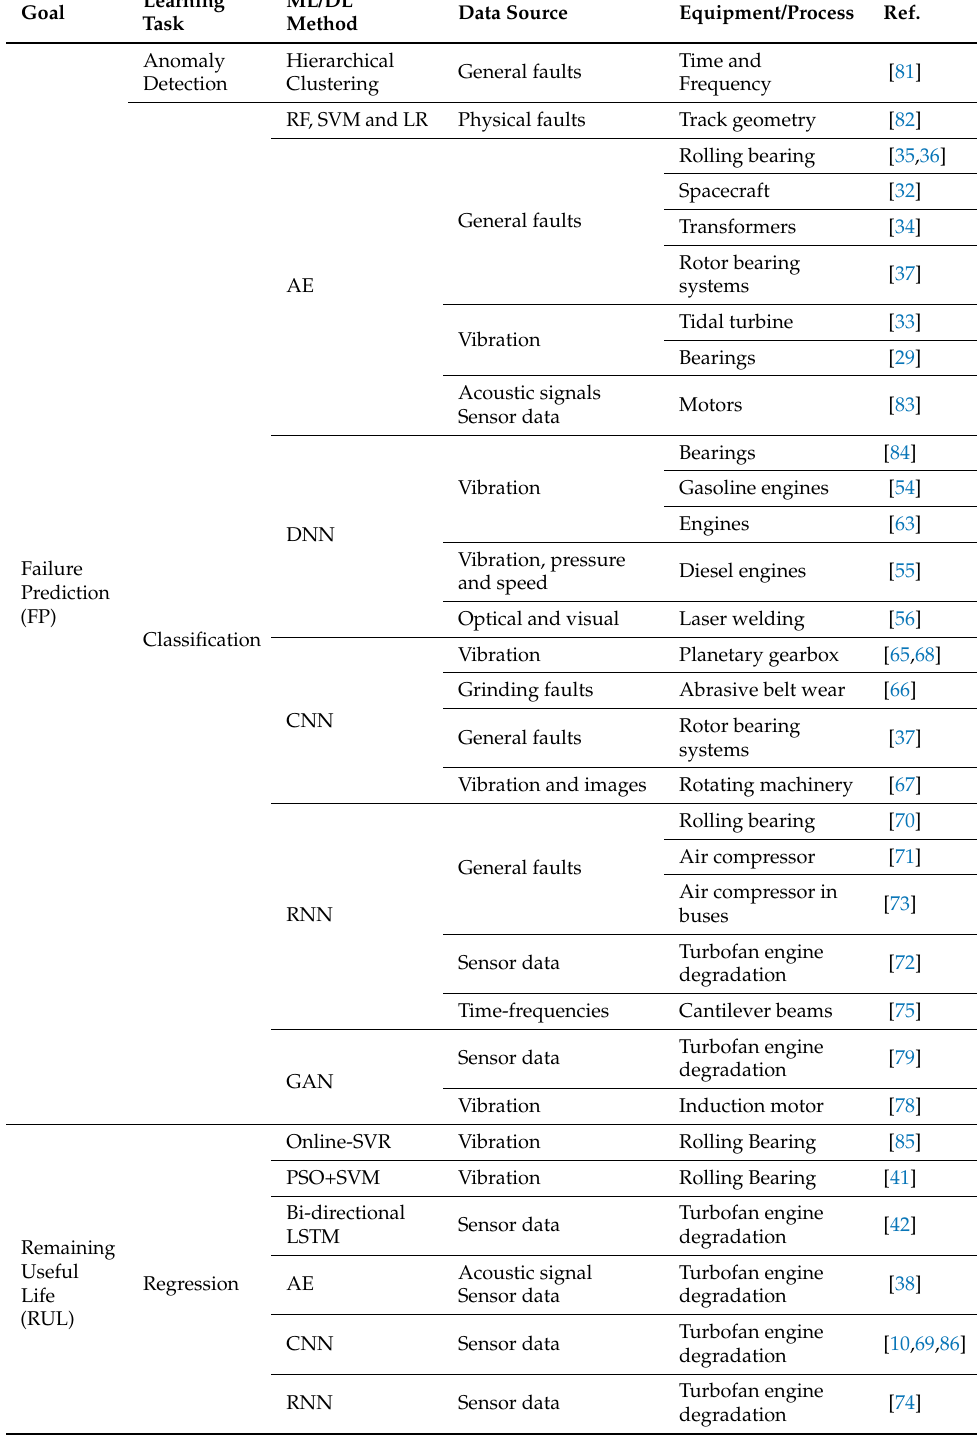
Table 1. ML/DL methods used for